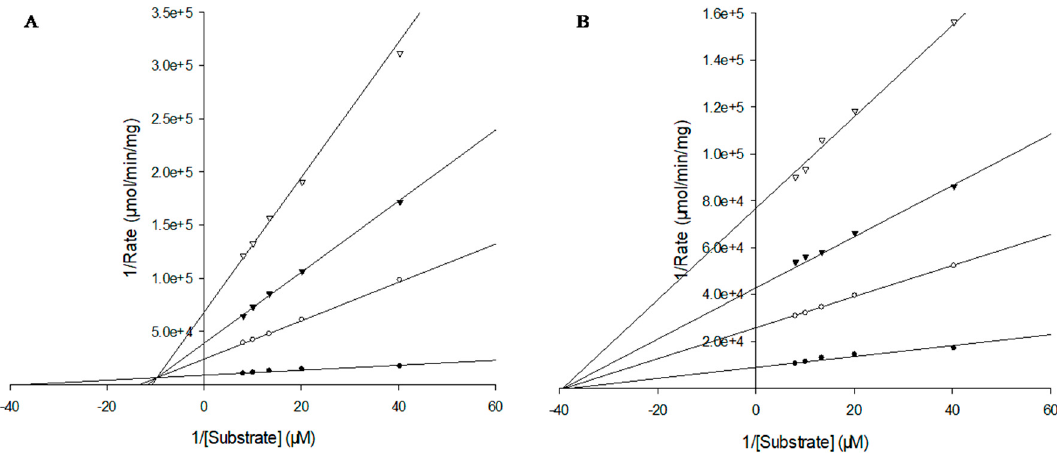
Figure 2. Lineweaver − Burk plot of ImiS catalyzed hydrolysis of imipenem in the absence and presence of 9 (left) and 13 (right). Inhibitor concentrations were 0 μ M ( ● ), 0.25 μ M ( ○ ), 0.5 μ M ( ▼ ), and 1.0 μ M ( ).